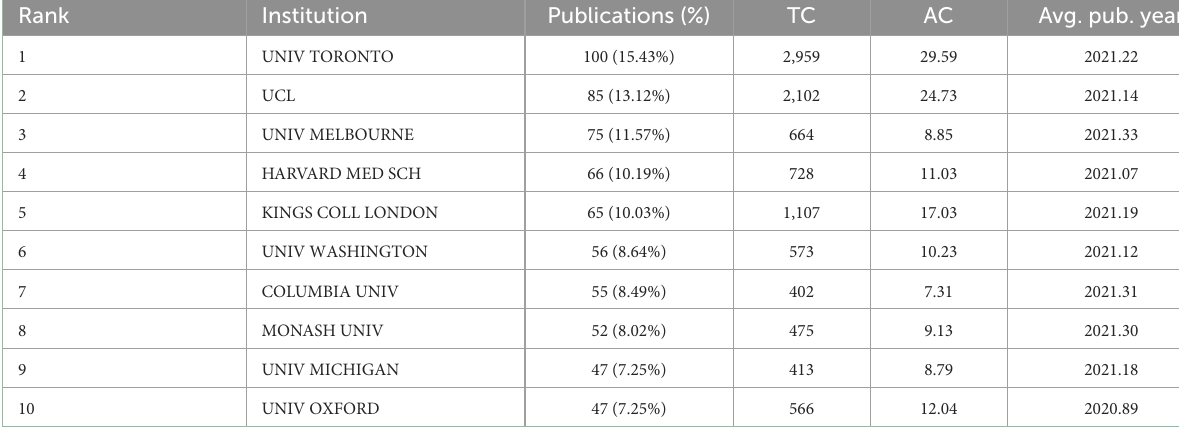
TABLE 2 Top 10 productive institutions according to